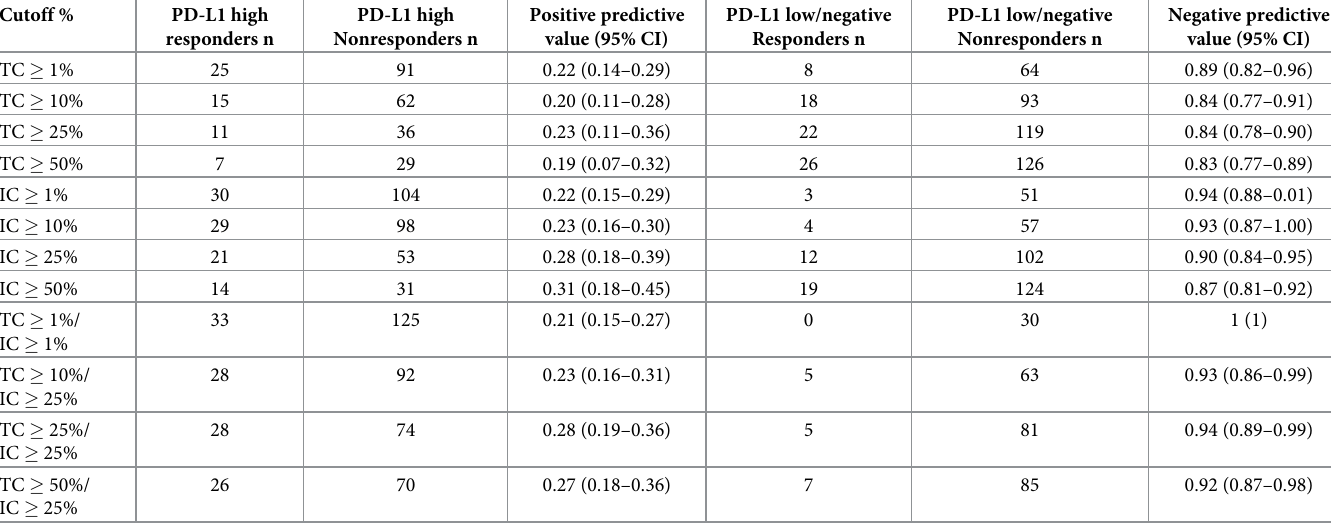
Table 1. Positive and negative predictive value of responders and non-responders in PD-L1 high and low negative